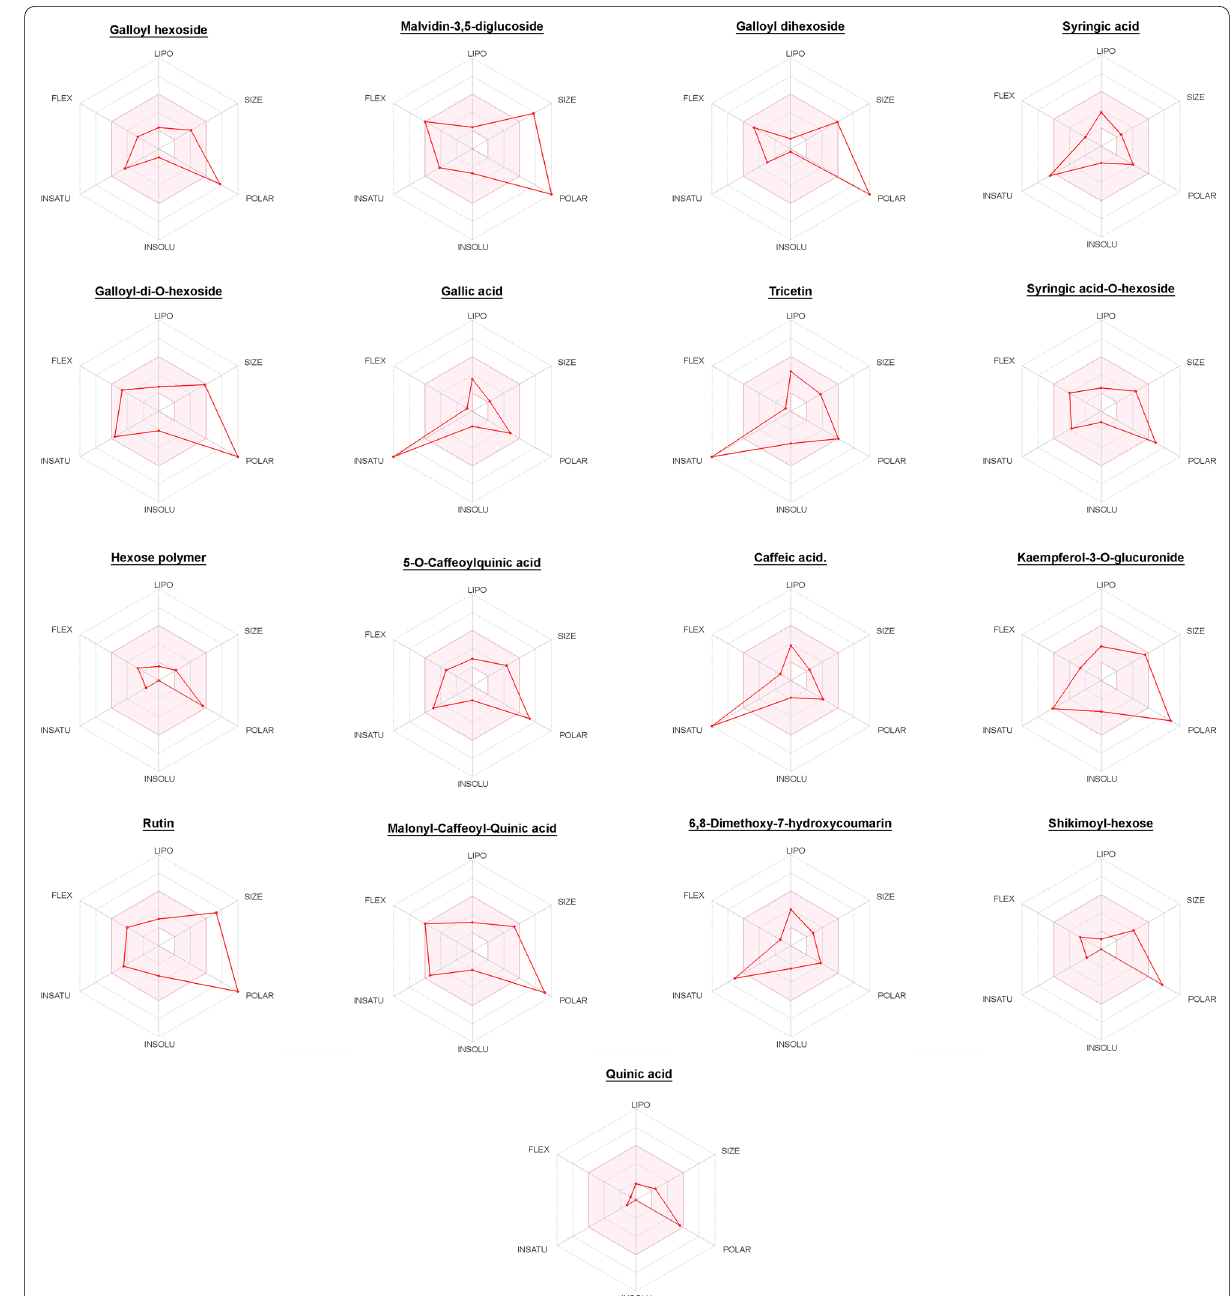
Fig. 4 Bioavailability radar of the polyphenols based on physicochemical indices ideal for oral